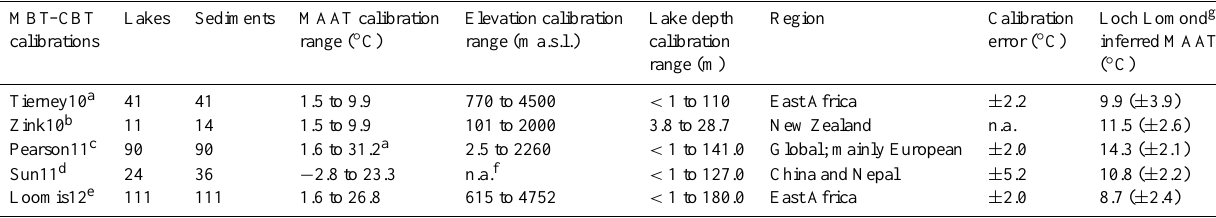
Table 6. Details of MBT–CBT calibrations and inferred MAATs from Loch Lomond sediments. MBT–CBT